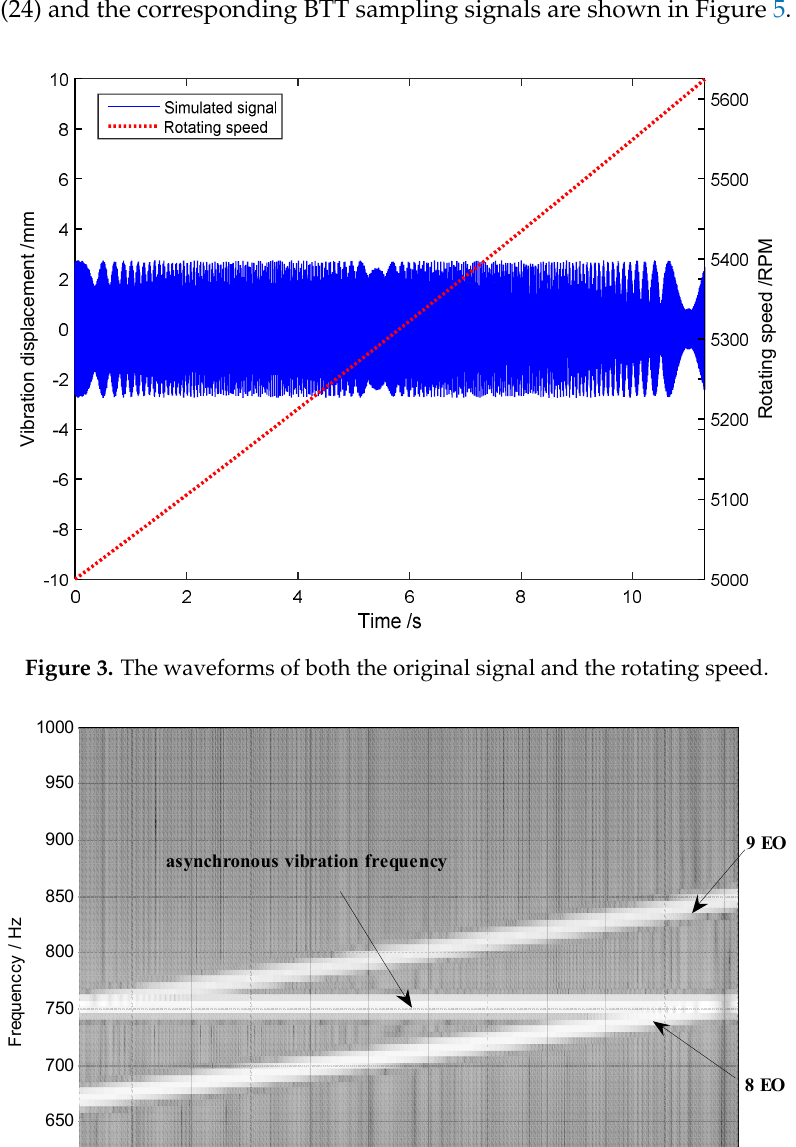
Figure 5. Uniformly sampled signals of three BTT sensors. Frequency spectrums of sampled signals from both each BTT sensor and three BTT sensors are shown in Figure 6. Obviously, we cannot see the resonant and asynchronous frequencies. The reasons may include: (i) The maximum sampling frequency is 281.25 Hz, so the sampled signals are under-sampled, and the corresponding power spectrums are not true; and (ii) the rotating speed is variable, so the sampled signals tend to be non-stationary. In this case, their frequency spectrums are also not accurate. Next, the angular-domain BTT vibration reconstruction algorithm in Section 3.1 is used to extract the true vibration frequencies. To apply Equation (11), the center order